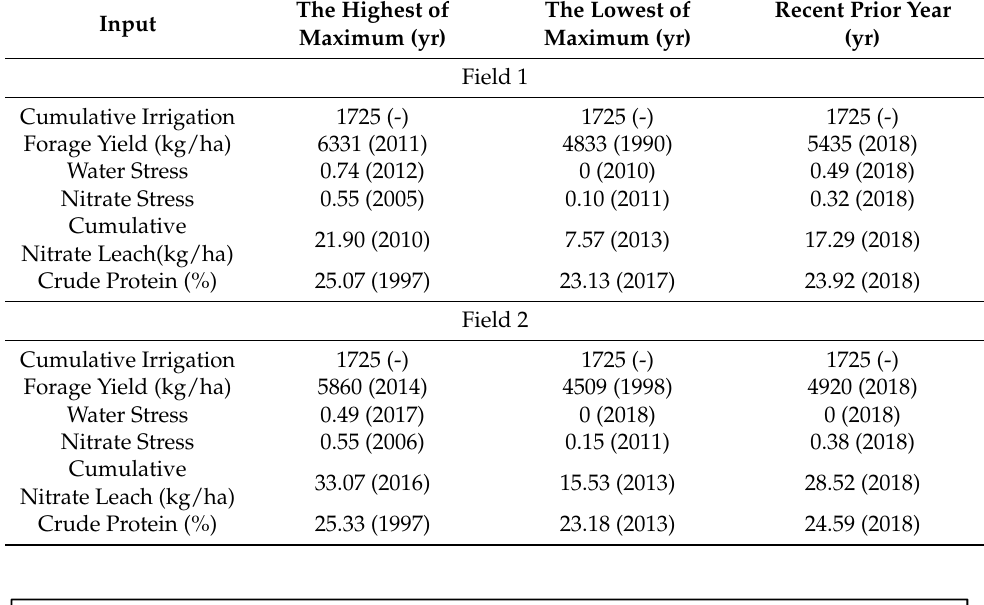
Table 8. Summary of the results from simulations (rounded to two decimal digit).